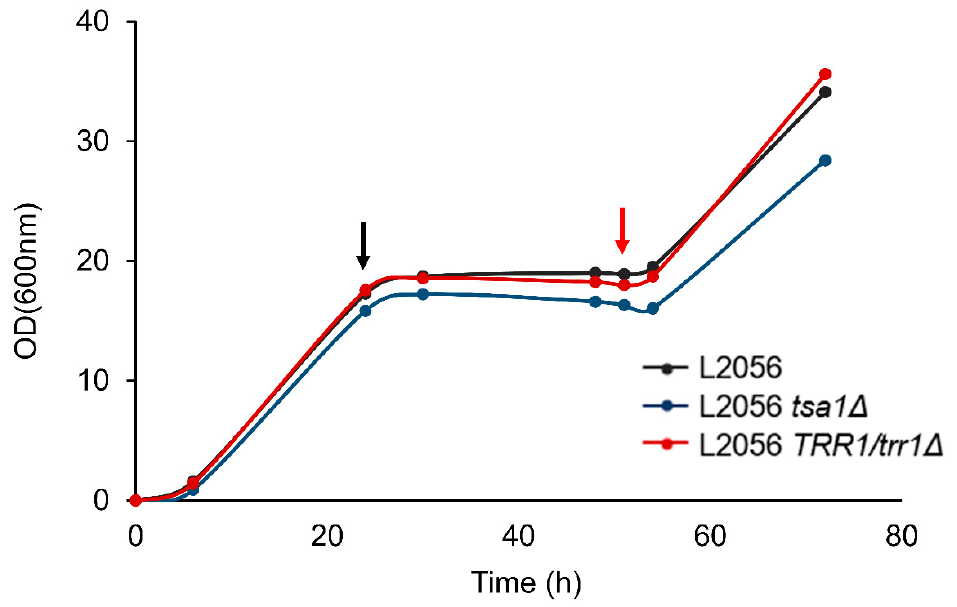
Figure 4. TSA1 deletion impairs growth in bioreactor. Growth measured by OD 600 of L2056, the L2056 tsa1 ∆ mutant and the L2056 trr1 ∆ / TRR1 strains in fermenters by a batch / fed-batch approach. A black arrow indicates when sucrose is consumed. A red arrow denotes when the fed-batch is initiated.